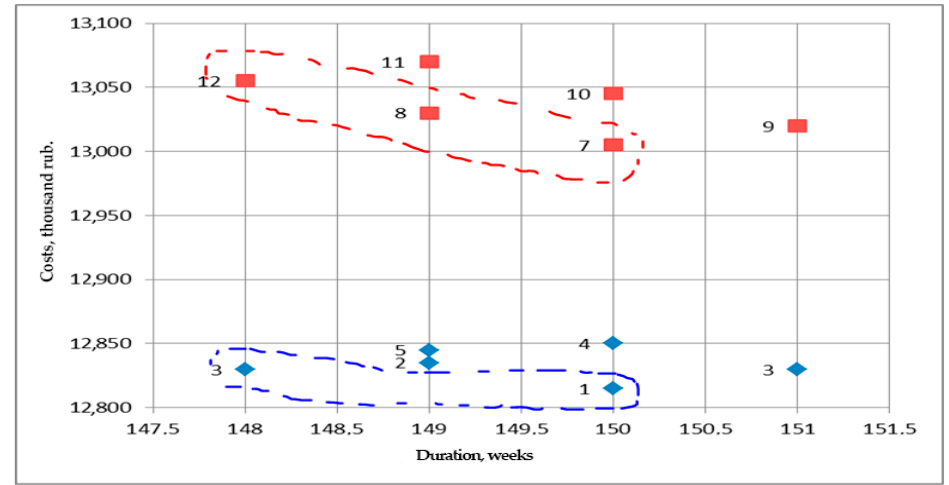
Figure 8. The graph showing the dependence of costs on the duration and technical level of the option. Source: designed by authors.